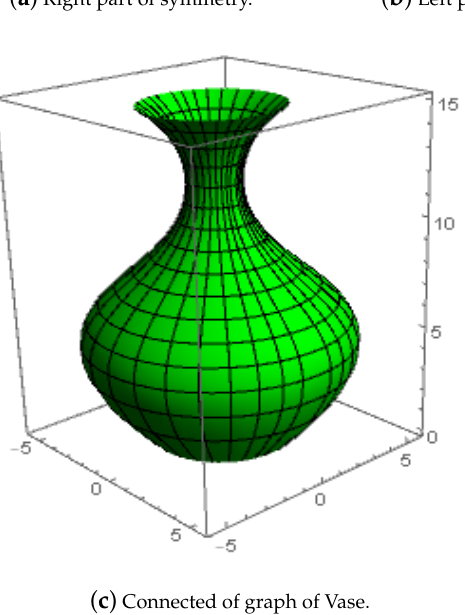
Figure 5. Construction of a symmetric figure of the